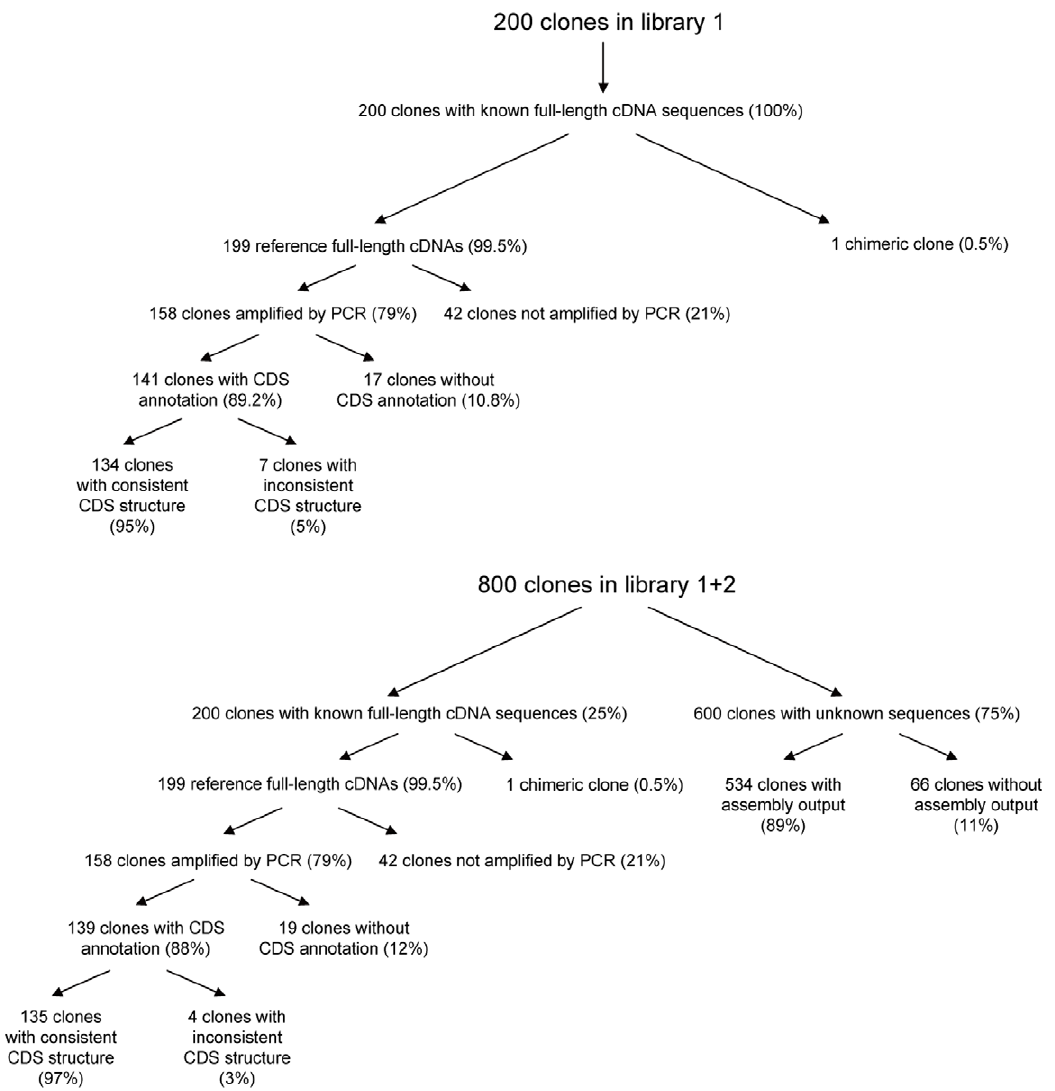
Figure 3. The clone fate for library 1 and 1 + 2. The diagram shows the accuracy evaluation process for the 200 human full-length cDNA clones in library 1 as well as the 800 human full-length cDNA clones in library 1 + 2. For library 1 + 2, the contigs associated to the clones with unknown sequences had an average length of 1,716 bp.